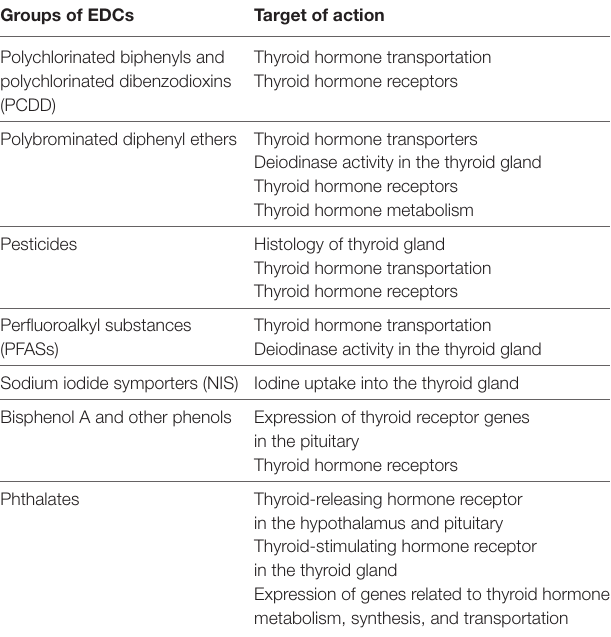
TAble 1 | Endocrine disrupting chemicals (EDCs) and target of action in the hypothalamus–pituitary–thyroid axis. groups of